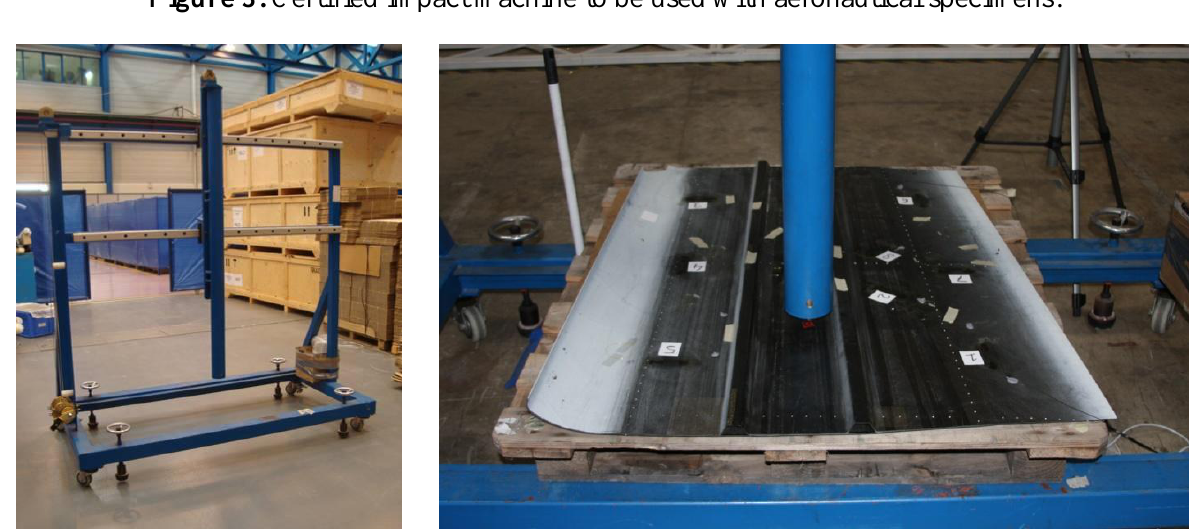
Figure 3. Certified impact machine to be used with aeronautical